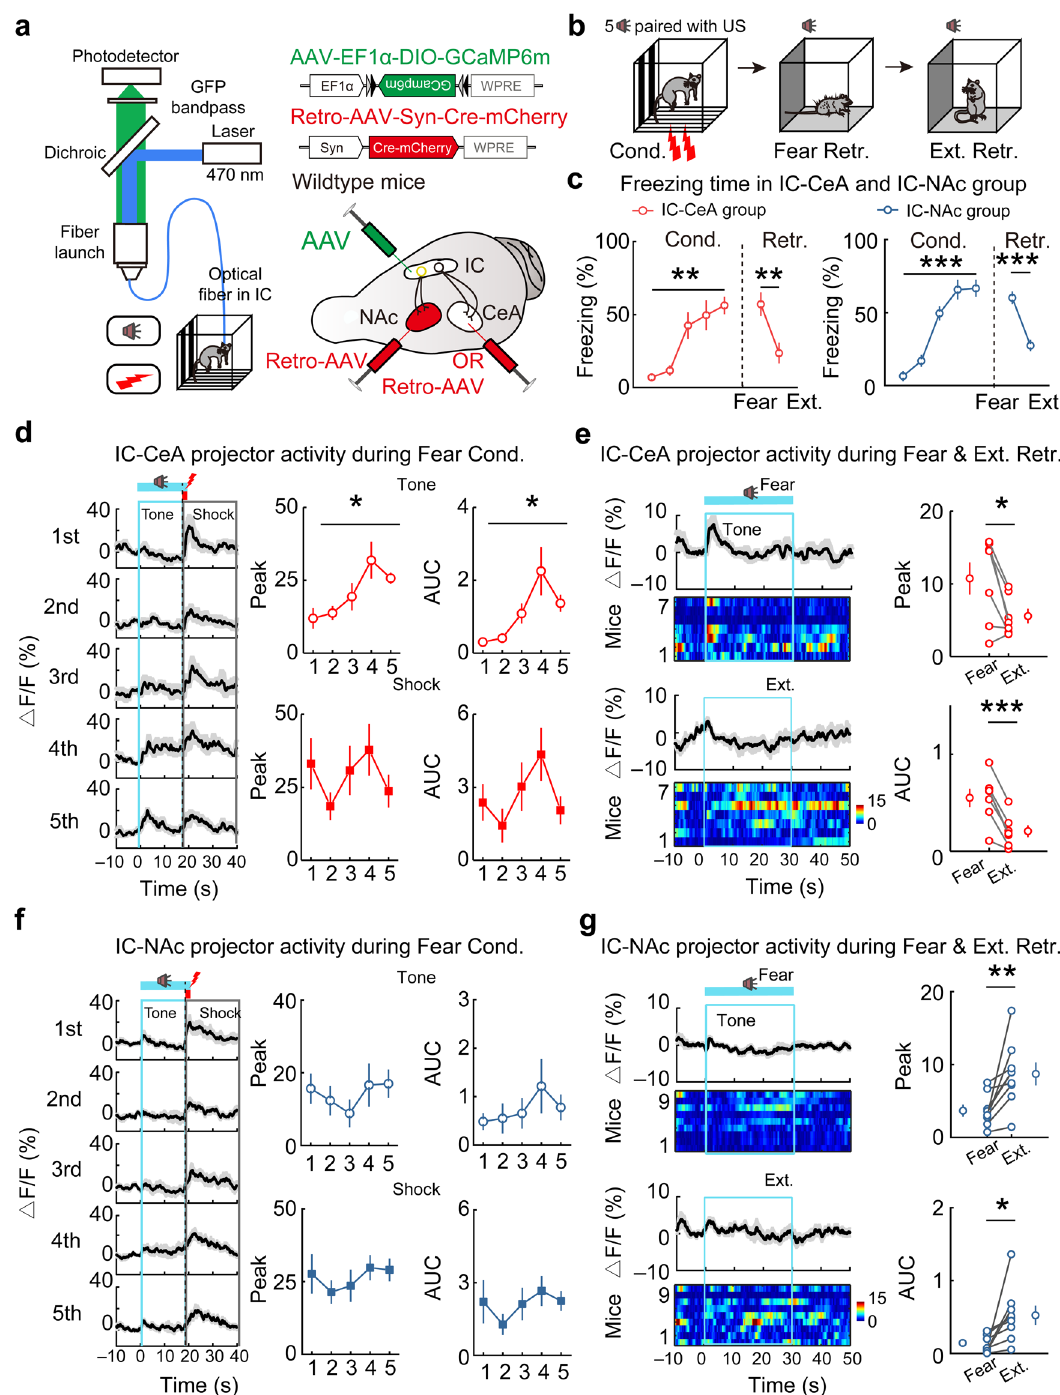
Fig. 4 | Distinct response patterns of IC-CeA and IC-NAc projectors to fear learning and fear- or extinction-memory retrieval. a Schematic diagram. b Behavioral protocols. c Freezing responses. IC-CeA projector group, n =7 mice; IC-NAcprojectorgroup, n =9mice.IC-CeA,Cond.: F (1.822,10.93) =14.40,** P =0.0010, one-way repeated-measure ANOVA; Retr.: t (6) =5.338, ** P =0.0018; two-tailed paired Student ’ s t test; IC-NAc, Cond.: F (2.490, 19.92) =51.50, *** P <0.0001, one-way repeated-measure ANOVA; Retr.: t (8) =6.674, *** P =0.0002; two-tailed paired Stu- dent ’ s t test. d – g Calciumsi g nals( Δ F/F). d , f Left:Averagecalciumsignalsalignedto theonsetoftheCSduringfearconditioning.Thicklines,mean;shadedareas,SEM. Right: the peak and the area under the curves (AUC) during tone (in cyanbox)and shock (in gray box). d Tone peak: F (1.932, 11.59) =4.688, * P =0.0331 ; tone AUC: F (1.358, 8.147) =6.409, * P =0.0283 ; shock peak: F (1.303, 7.818) =1.508, P =0.2663; shock AUC: F (1.803, 10.82) =2.373, P =0.1426, one-way repeated-measure ANOVA. f Tone peak: